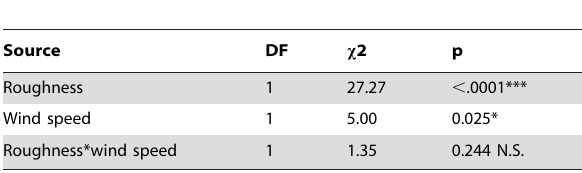
Table 4. Effects of beach roughness and wind direction on direction wheeled by C. dorsalis media